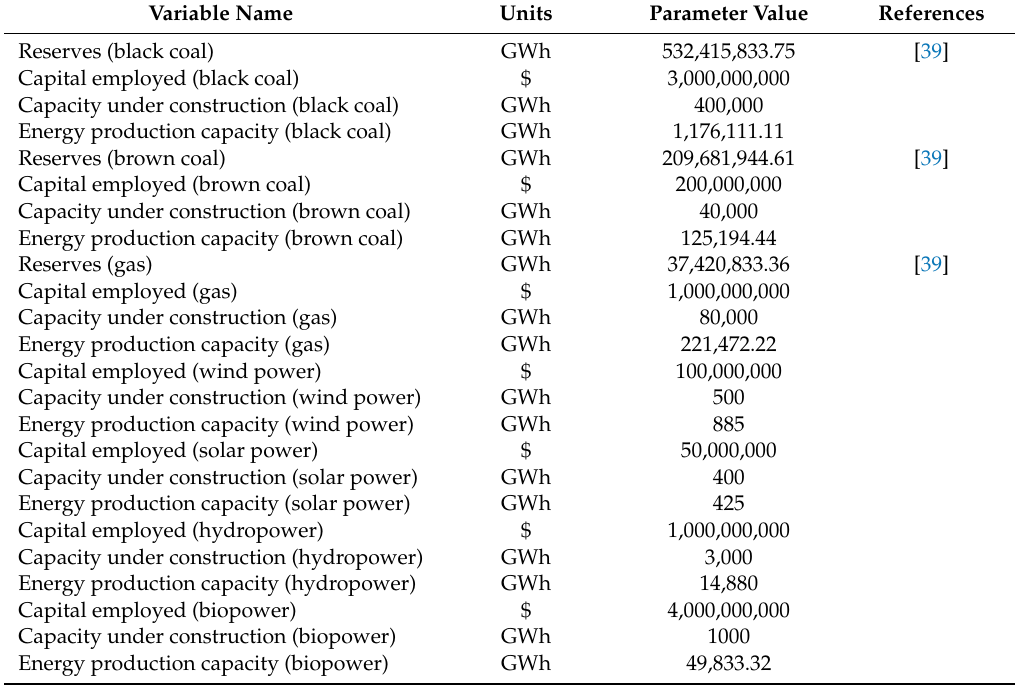
Table A1. Parameters used for stocks (the parameter value column represents initial